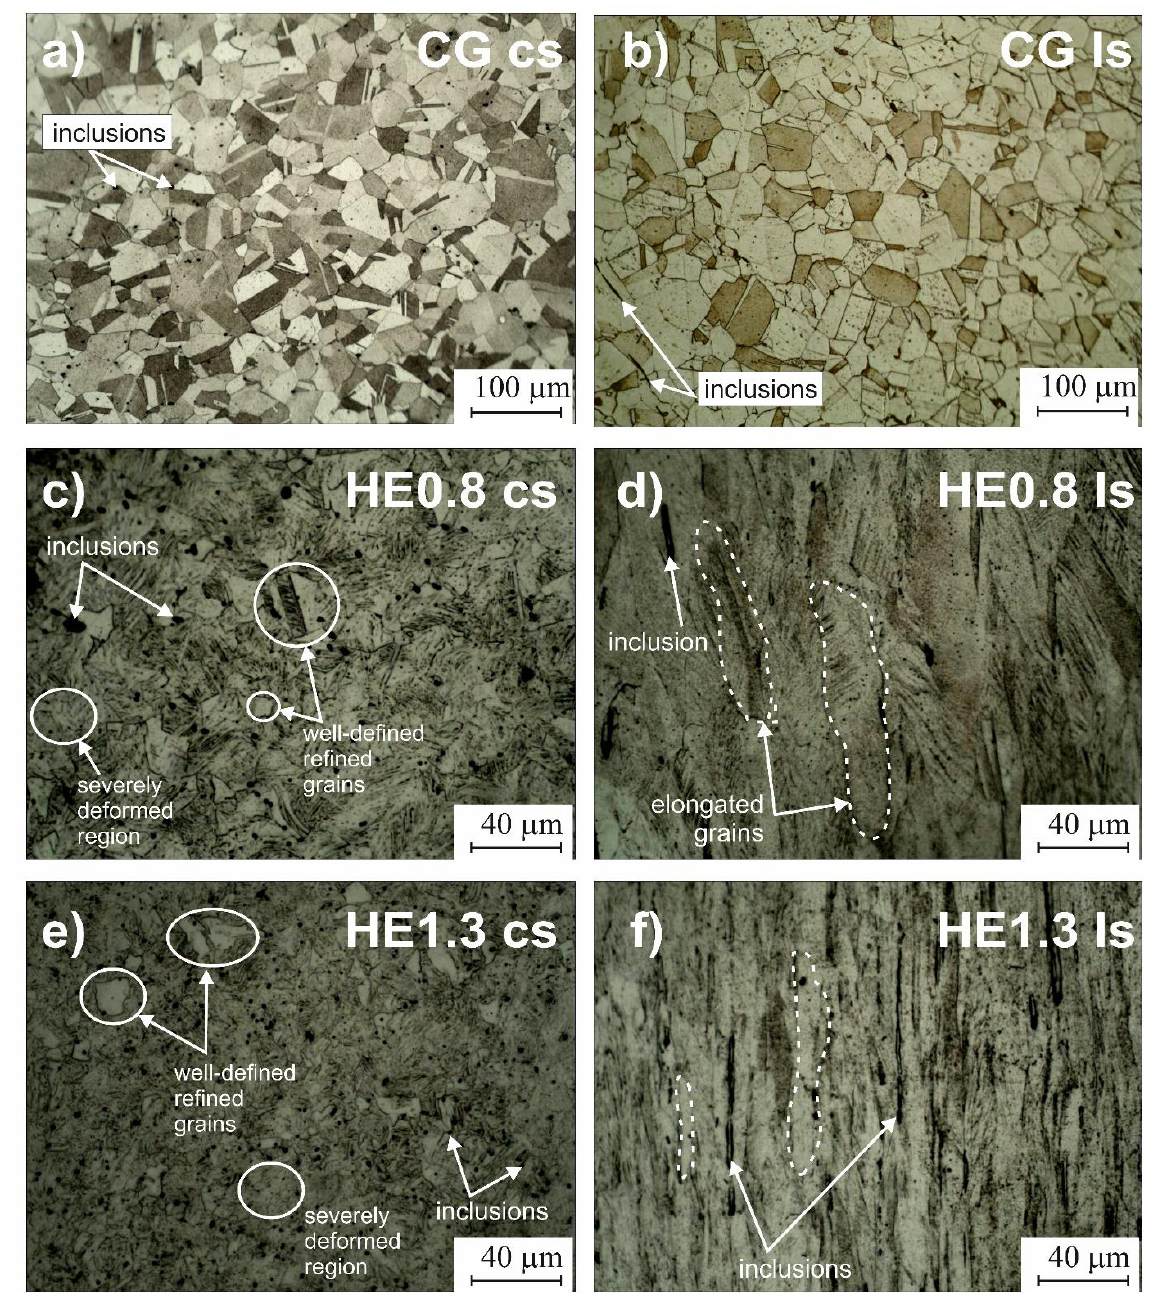
Figure 2. Light microscope observations of the microstructure of 316L stainless steel on the cross-section: ( a ) CG, ( c ) HE0.8 ( e ) HE1.3 samples and on the longitudinal section: ( b ) CG, ( d ) HE0.8 ( f ) HE1.3 samples.